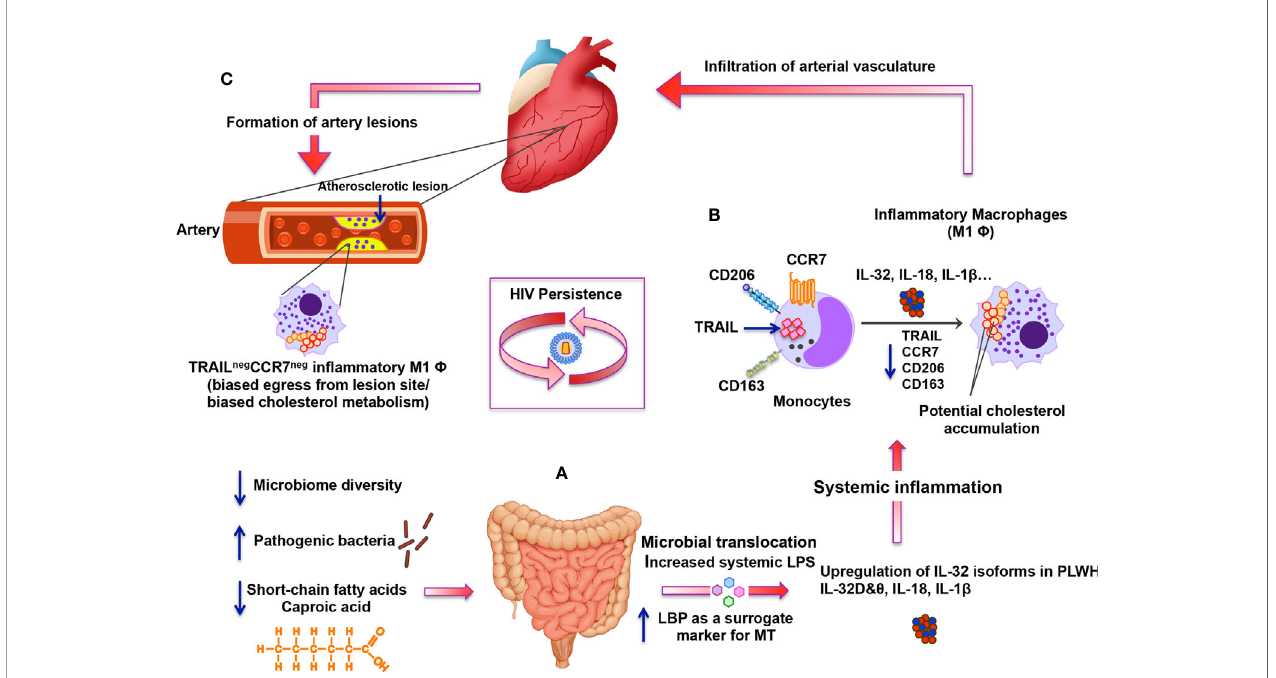
FIGURE 7 | Schematic representation for the altered gut microbiome and metabolome under persistent HIV infection and their impact on systemic in fl ammation, IL- 32 upregulation and atherosclerosis. (A) Under persistent HIV infection, decreased microbiome diversity and higher abundance of pathogenic bacteria combined with lower levels of short-chain fatty acids (mainly caproic acid) are associated with increased microbial translocation (MT) with high levels of systemic LPS and LBP. MT induces systemic in fl ammation and enhances expression of speci fi c IL-32 isoforms together with other in fl ammatory cytokines such as IL-18 and IL-1 b . (B) Speci fi c IL-32 isoforms (IL-32 b , g and potentially IL-32D isoforms) induce the maturation of monocytes into in fl ammatory macrophages with M1 phenotype (CD206 neg CD163 neg ) having decreased expression of CCR7 and TRAIL (likely mediated by up-regulation of IL-18). In fl ammatory TRAIL neg monocytes/macrophages are known to have biased cholesterol metabolism. (C) These TRAIL neg monocytes/macrophages are then hypothesized to in fi ltrate vascular endothelium of the heart and contribute to the atherosclerotic lesion formation. IL-32-mediated down-regulation of CCR7 on TRAIL neg monocytes/macrophages may also contribute to the biased egress of these cells from the lesion-forming site, which would foster